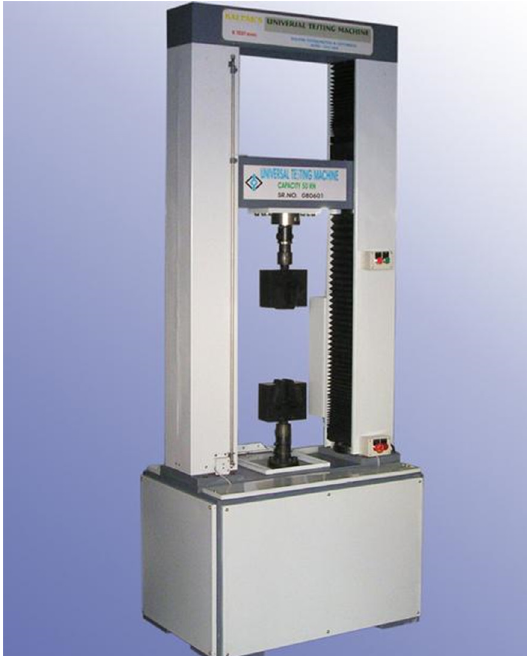
Figure 2. Universal Testing